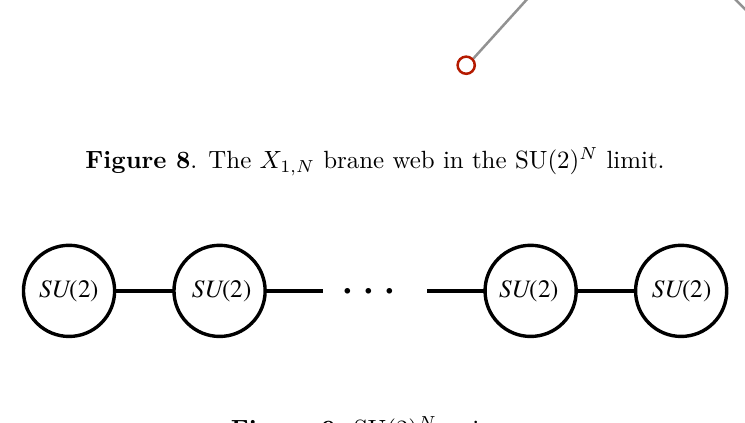
Figure 9 . SU(2) N